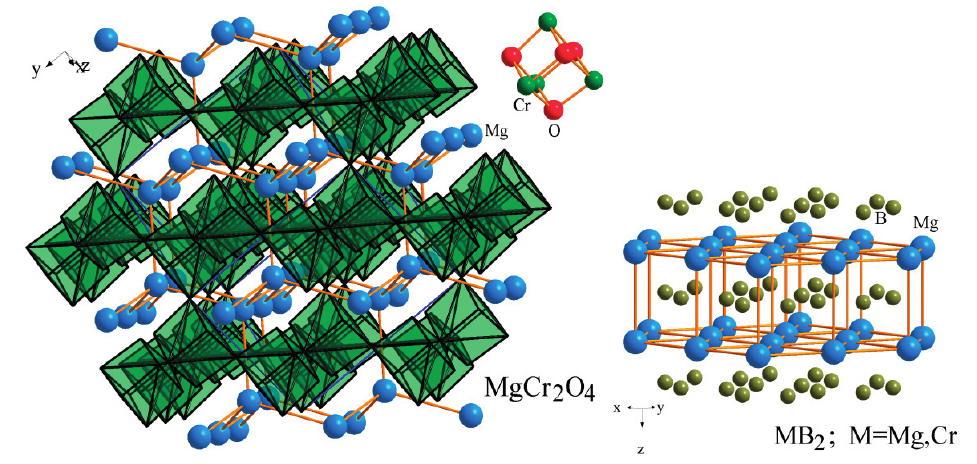
Figure 1. Laying atoms and some fragments in the structure or chromium magnesium diboride and MgCr 2 O 4